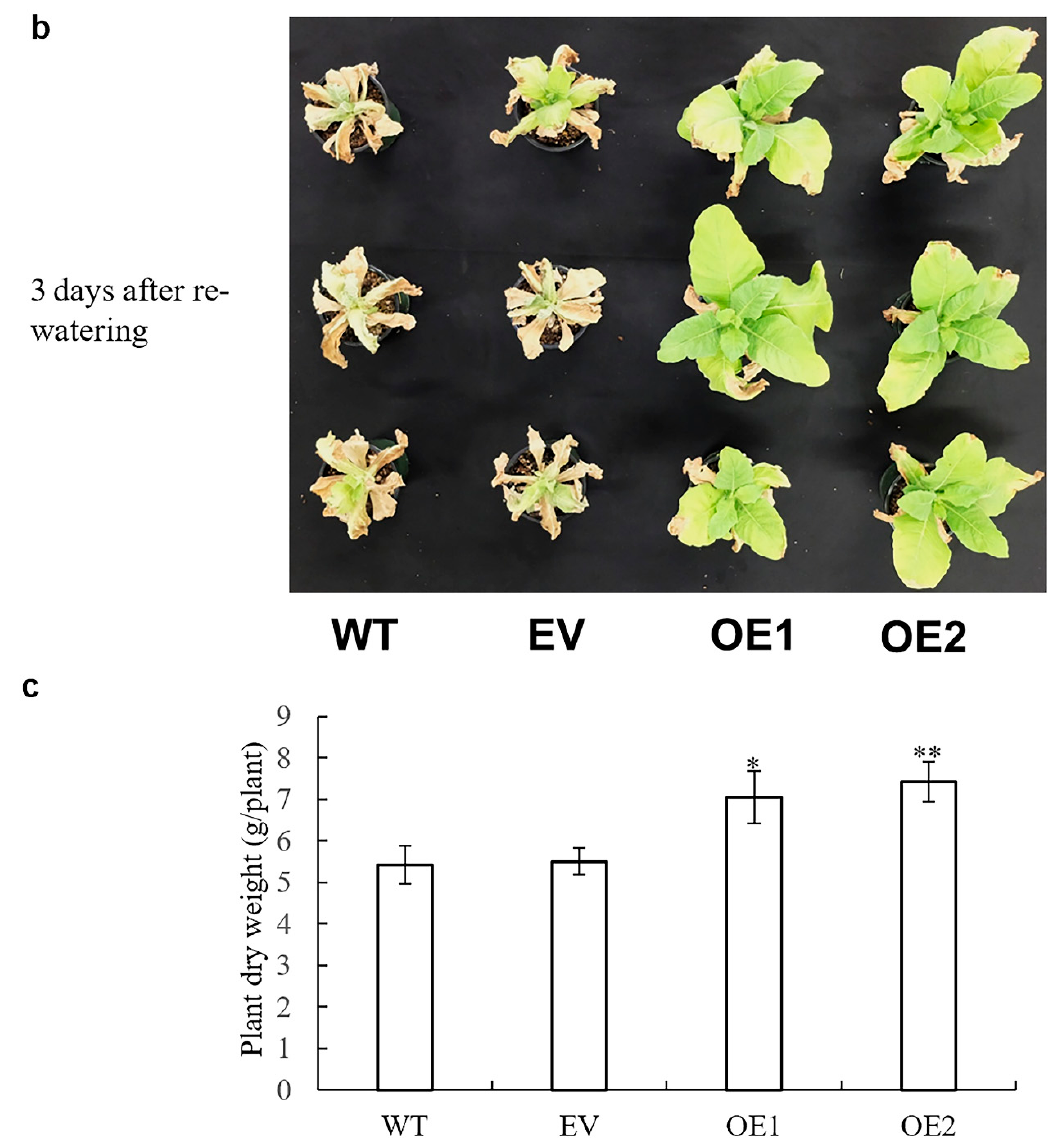
Figure 7. Responses of the AaPEPC1 -overexpressing tobacco plants under drought stress. Phenotypes of transgenic plants 13 expressing AaPEPC1 (OE1 and OE2) or as well as empty vector (EV), and wild-type plants (WT) grown in pots under drought stress ( a ) and after re-watering ( b ). Transgenic and WT were grown in soil for 15 days without watering. ( c ) Dry weight of transgenic and WT plants. Values represent means ± SD (n = 3). * and ** indicate significant difference from that of WT at p < 0.05 and p < 0.01, respectively, by one-way ANOVA analysis with post-hoc Tukey